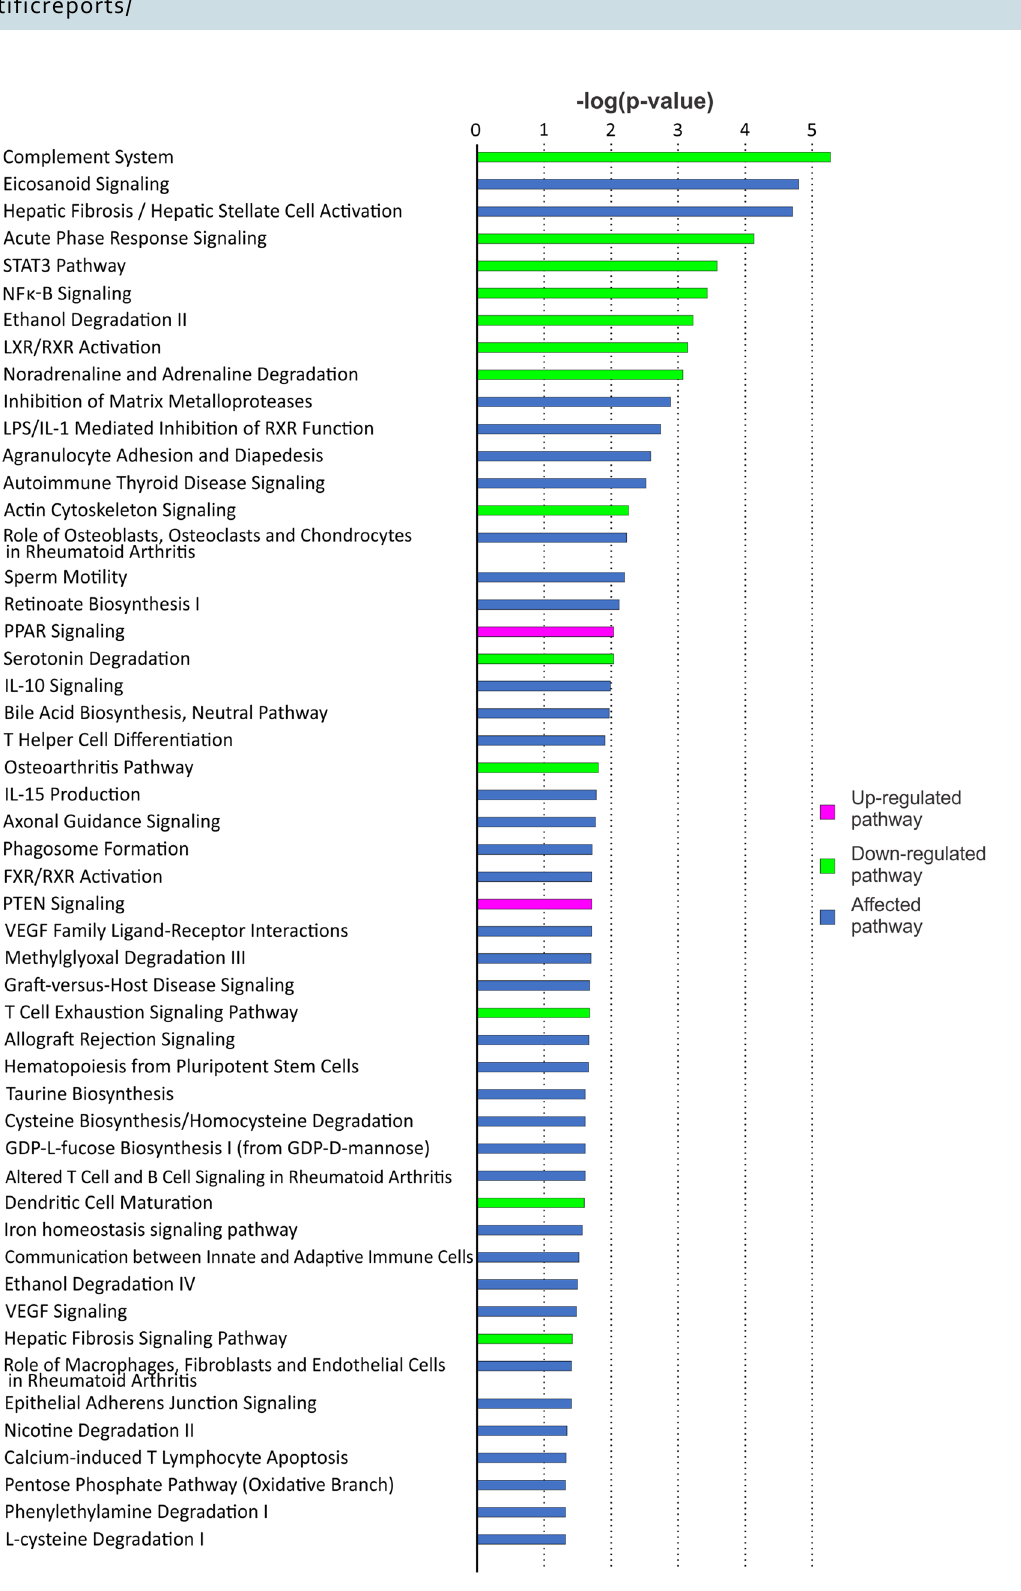
Figure 4. Signaling pathways in HF human SAN predicted by IPA. HF indicates heart failure; IPA, Ingenuity pathway analysis; SAN, sinoatrial node. The graph was generated with IPA (Winter Release December 2019,